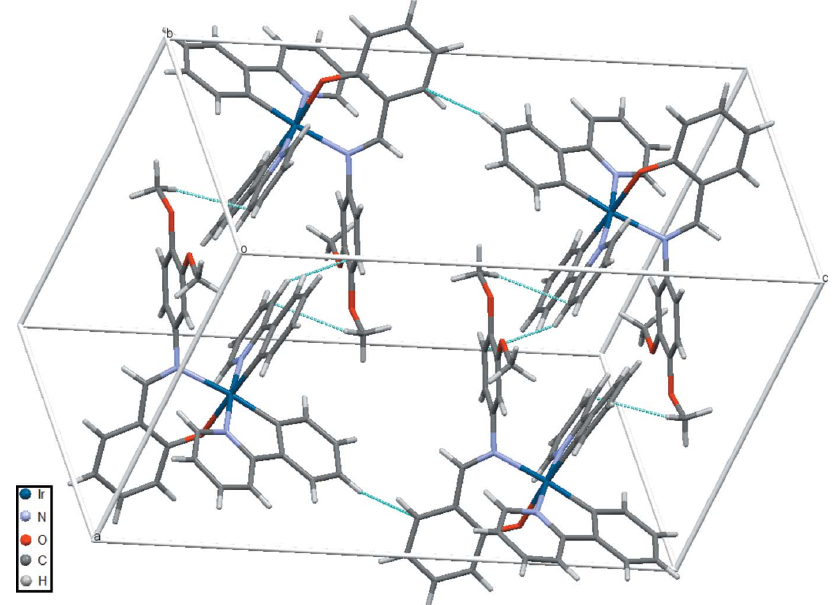
Figure 2 Packing plot of the molecular components in the title compound. Cyan lines represent intermolecular short contact. Solvent molecules are omitted for